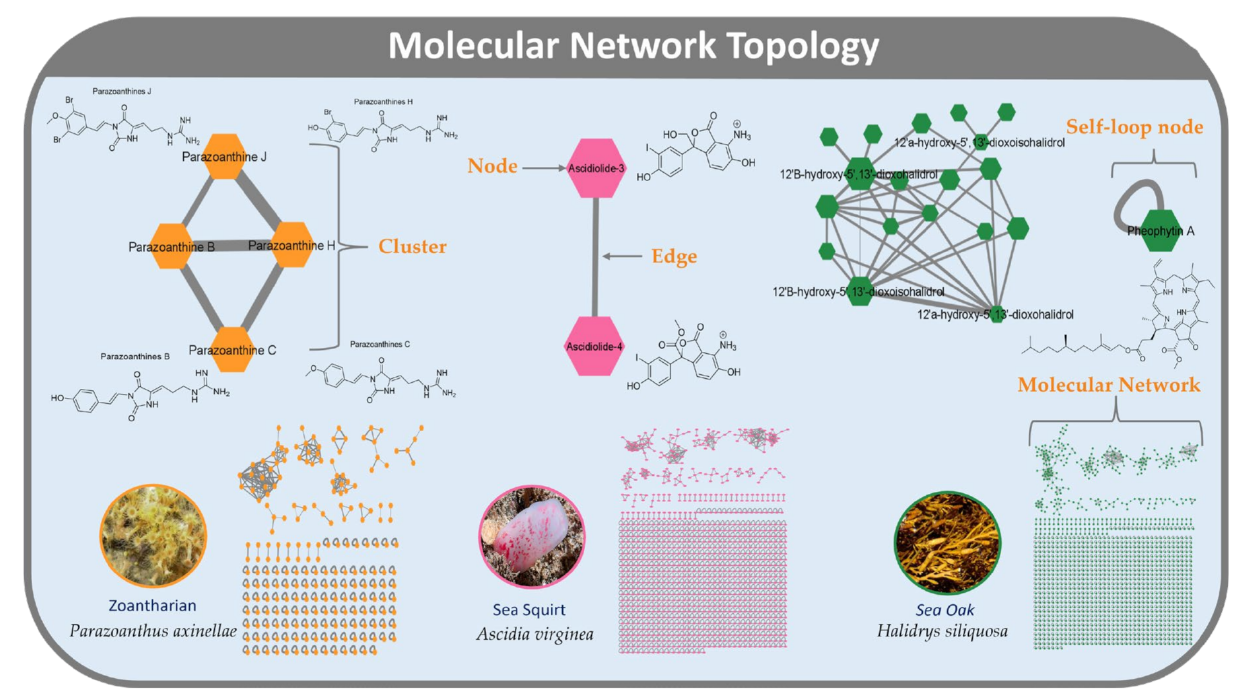
Figure 1. Annotated molecular networks of the studied samples, Parazoanthus axinellae (yellow, left ), Ascidia virginea (pink, centre), and Halidrys siliquosa (green, right ), showing the diverse range of metabolites. Elements of molecular networking topology are